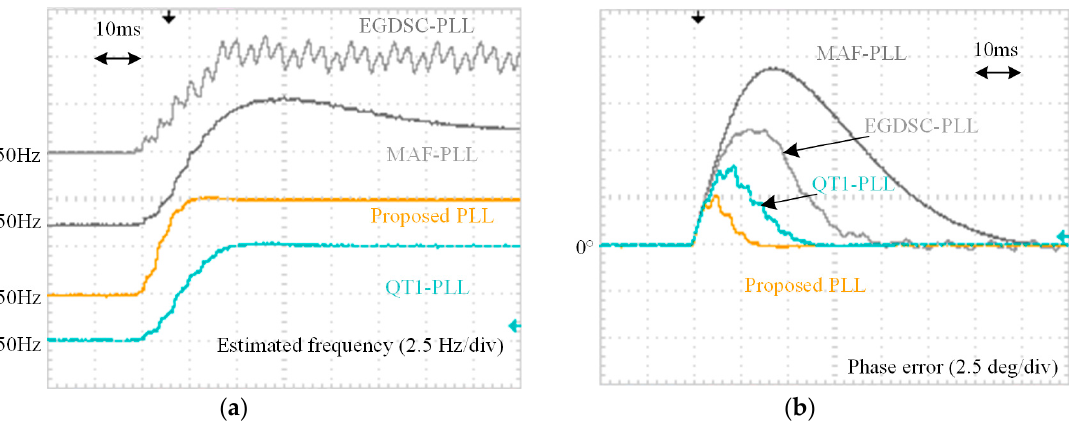
Figure 26. The experimental results of test case 3. ( a ) Estimated frequency and ( b ) phase error.